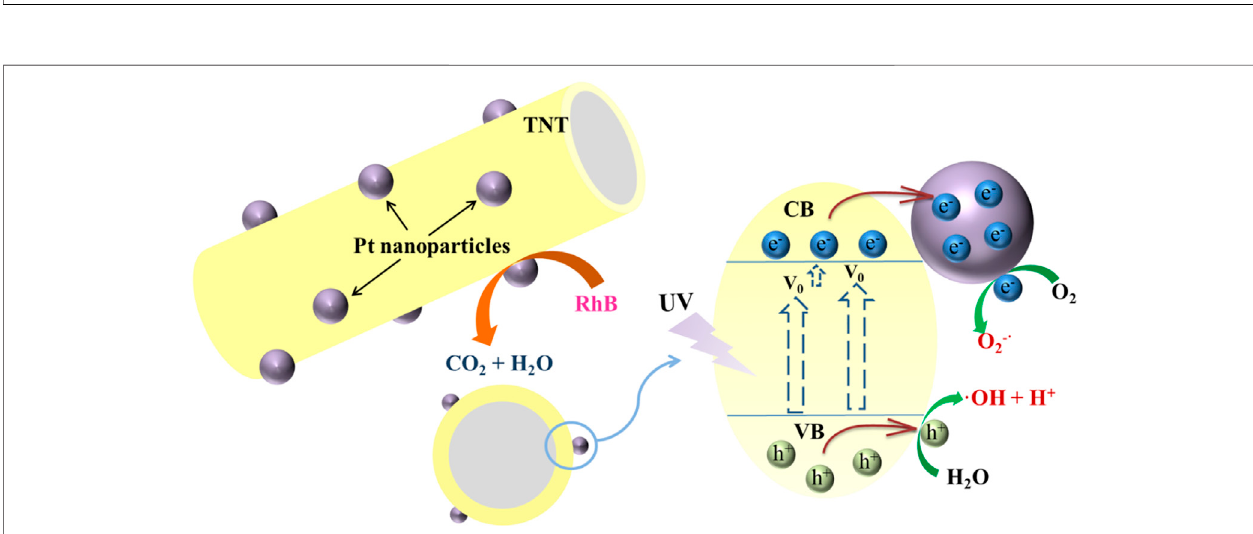
FIGURE 7 | The possible photocatalytic mechanism of TNT-PT for RhB